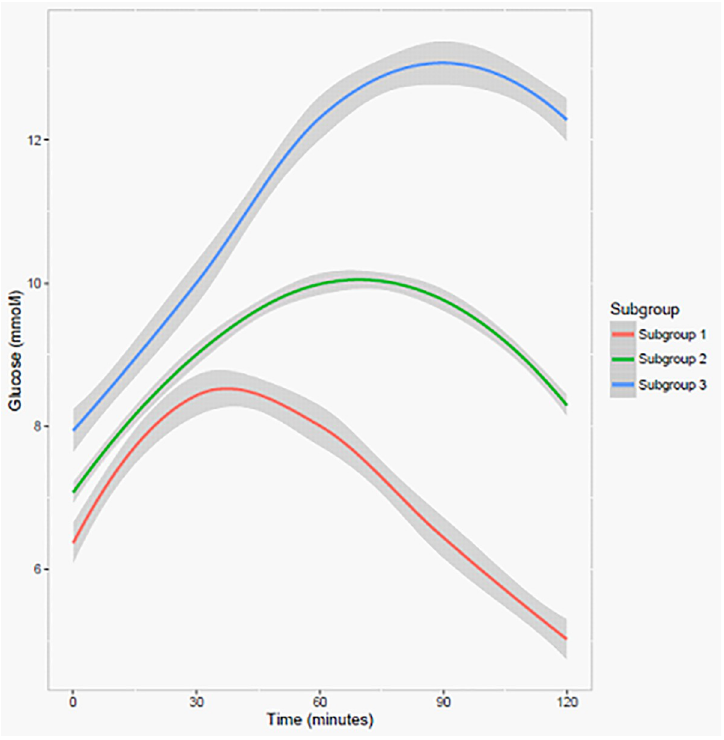
Fig 2. Glucose curve subgroups following a MMT depicting estimated mean trajectories with 95% confidence intervals identified by the latent class trajectory analysis in individuals with type 2 diabetes (n = 787).